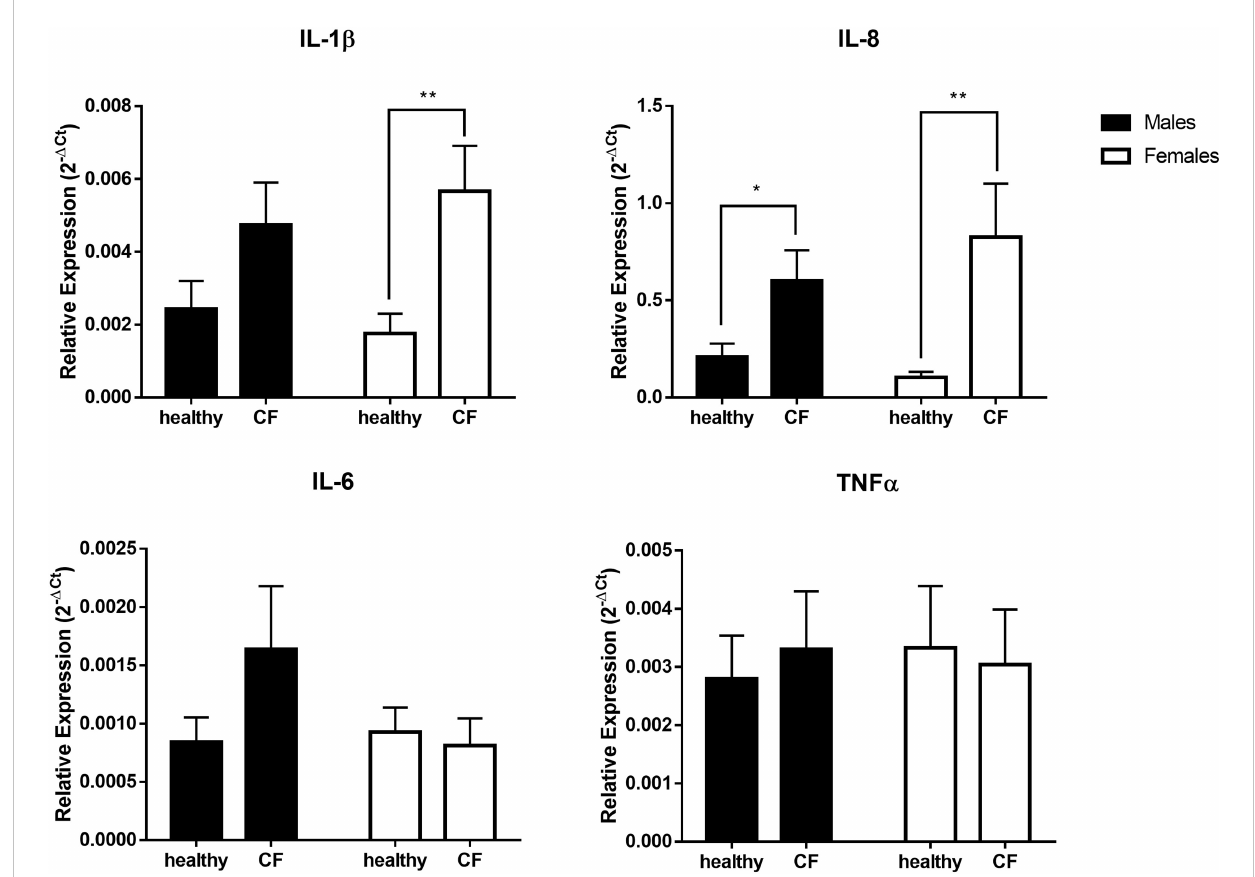
FIGURE 2 Sex-based assessment of in fl ammatory cytokines expression in blood leukocytes from male healthy controls (n=10) versus male CF patients (n=15) and female healthy controls (n=10) versus female CF patients (n=14). The values were normalized with two internal controls, GAPDH and b -actin. Graphs show the mean ± SEM. *p<0,05; **p<0,01 (Mann Whitney U